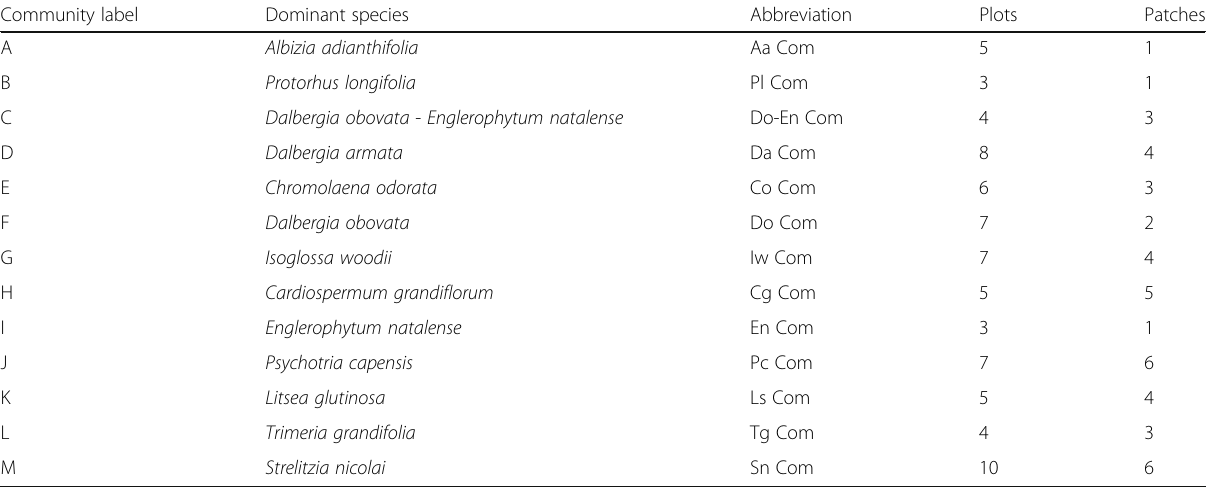
Table 4 Details of plant communities observed across the coastal lowland and scarp forests, and the number of their representative plots and forest patches each community occurred in Community label Dominant species Abbreviation Plots